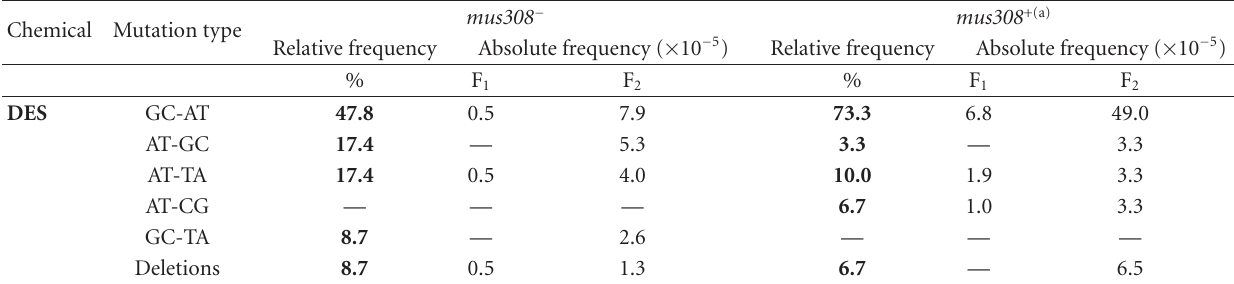
Table 3: Relative and absolute mutation frequencies (F 1 and F 2 values expressed as mutation frequencies × 10 − 5 ) of the di ff erent mutation types constituting the mutation spectra induced by DES in postmeiotic male germ cells, in mus 308 − and mus 308 + conditions. Chemical Mutation